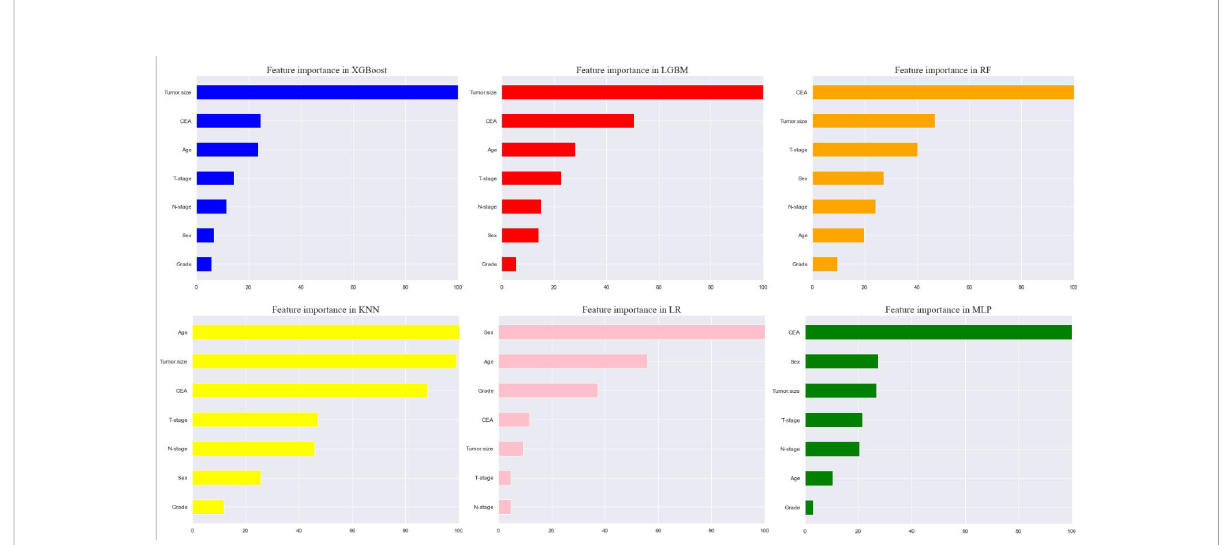
FIGURE 3 Feature importance of six models. The plot shows the ranking of six models ’ relevant volume of features. Abbreviations: LGBM, light gradient boosting; XGB, extreme gradient boosting; RF, random forest; LR, logistic regression; KNN, K-nearest neighbor; MLP, multilayer